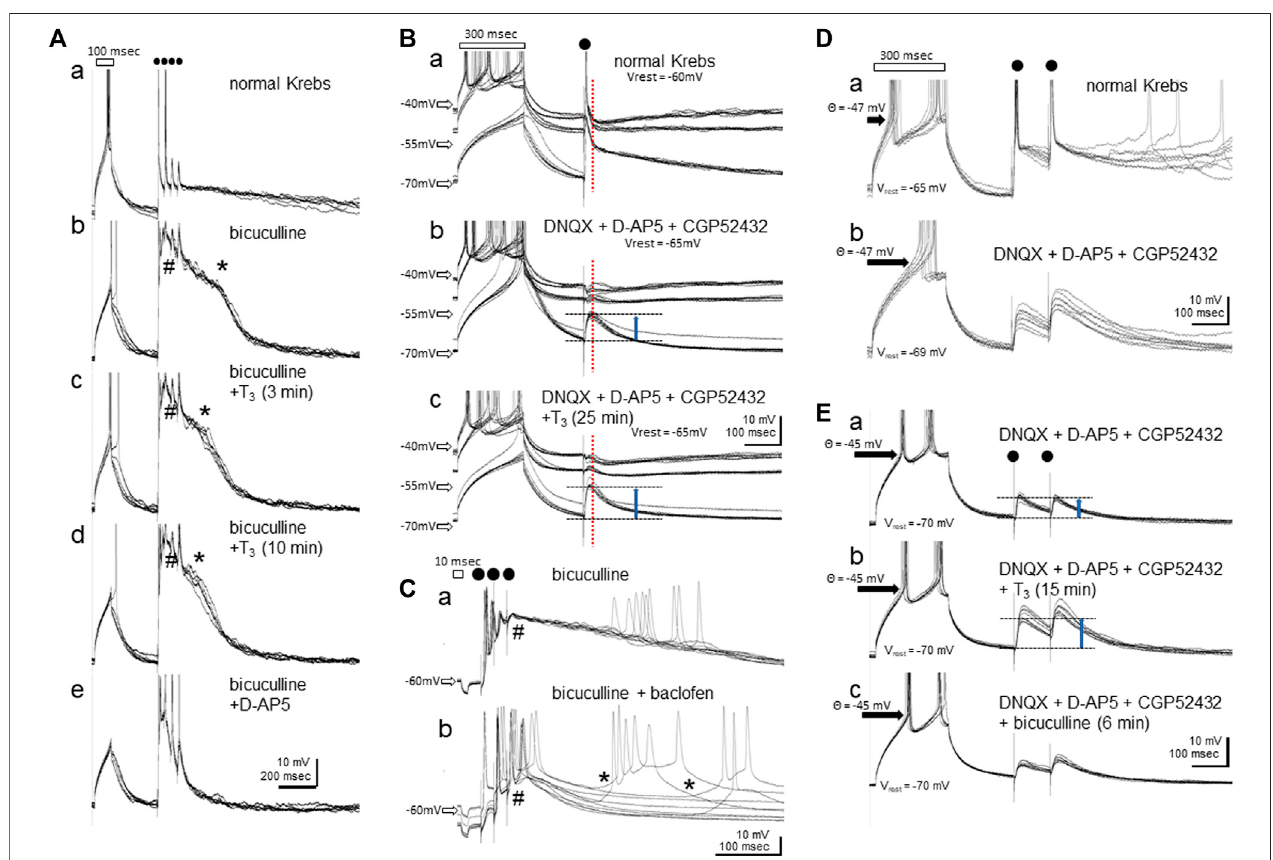
FIGURE 5 | Effects of bath-applied T 3 (40 μ M) on the membrane potentials in IMM neurons. (A – C) show recordings using normal Cl − pipette solution. (D,E) show recordingswithhigh-Cl - electrodeandGABA-Aresponsesrevealedasdepolarization. (Aa-e) T 3 suppressedtheNMDA-plateau.Initialdepolarizingcurrentinjection(indicated byarectangle,100 msec)wasfollowedbyfourrepetitivelocalelectricshocks(dots);#indicatestheinitialonsetphaseoftheNMDAplateaupotentialbybicuculline,and*the shoulder (onset of the decaying phase) of it. Six consecutive traces recorded at 10 s intervals are shown for each. (Ba-c) Responses recorded at three steps of tonic current injection through the recording electrode. Vertical dashed red line indicates the peak GABA-A response that is reversed at ca. − 50 mV. Vrest means the resting membranepotentialwithoutcurrentinjection. (Ca-b) BaclofeninducedsporadicNMDA-plateaudepolarization(*). (Da-b) BlockadeofAMPA,NMDAandGABA-Breceptors unmaskedGABA-Areceptormediateddepolarization. (Ea-c) FurtheradditionofT 3 enhancedtheGABA-Adepolarization(upwardbluearrows).Noeffectswerefoundinthe resting membrane potential (V rest = − 70 mV), membrane resistance, or threshold for spike generation ( θ = − 45